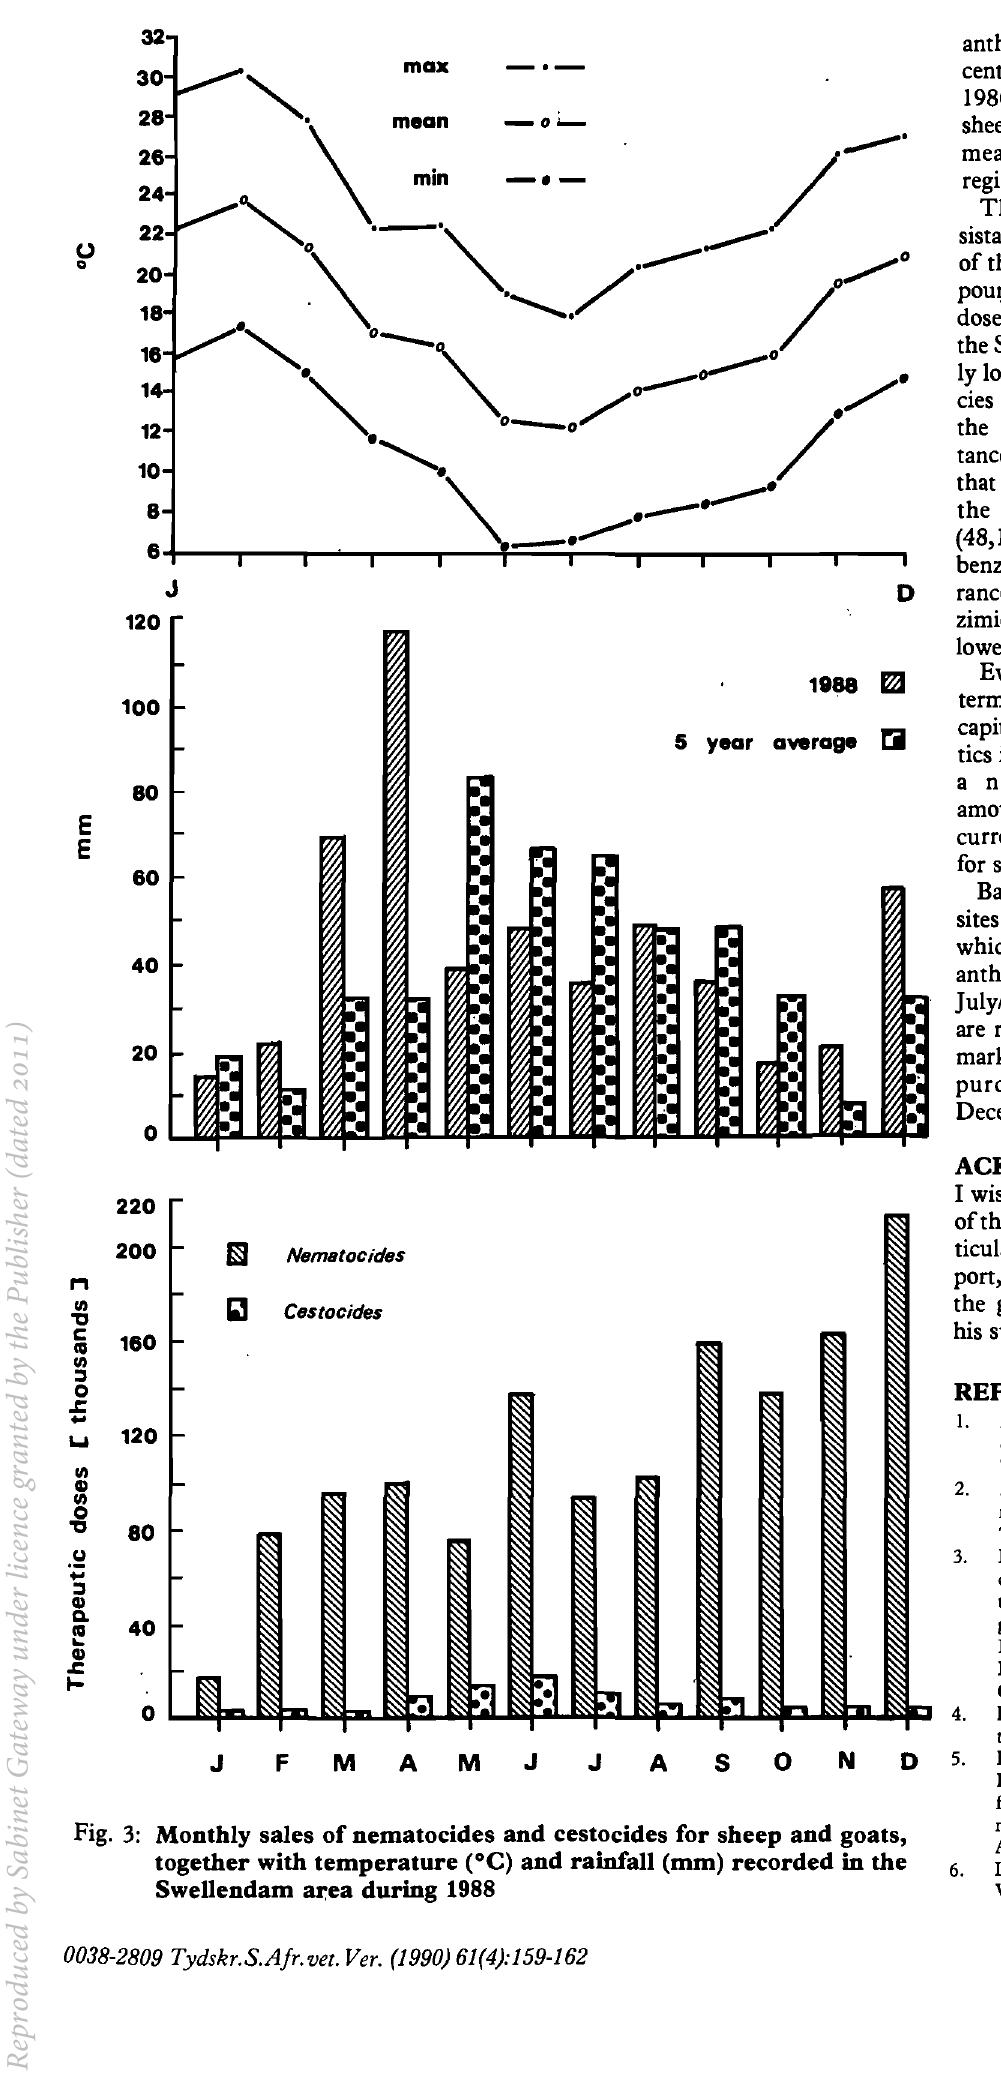
Fig. 3: Monthly sales of nematocides and cestocides for sheep and goats, together with temperature (0C) and rainfall (mm) recorded in the Swellendam at:ea during